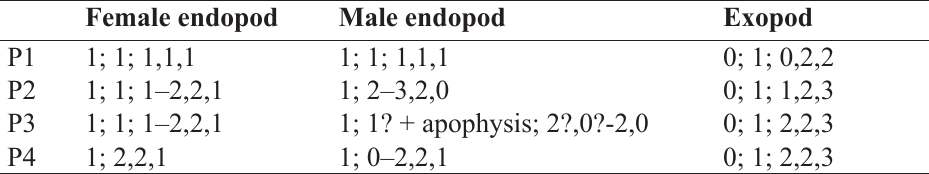
Table 3. Armature formula of P1–P4 of Canthocamptus Westwood, 1836.